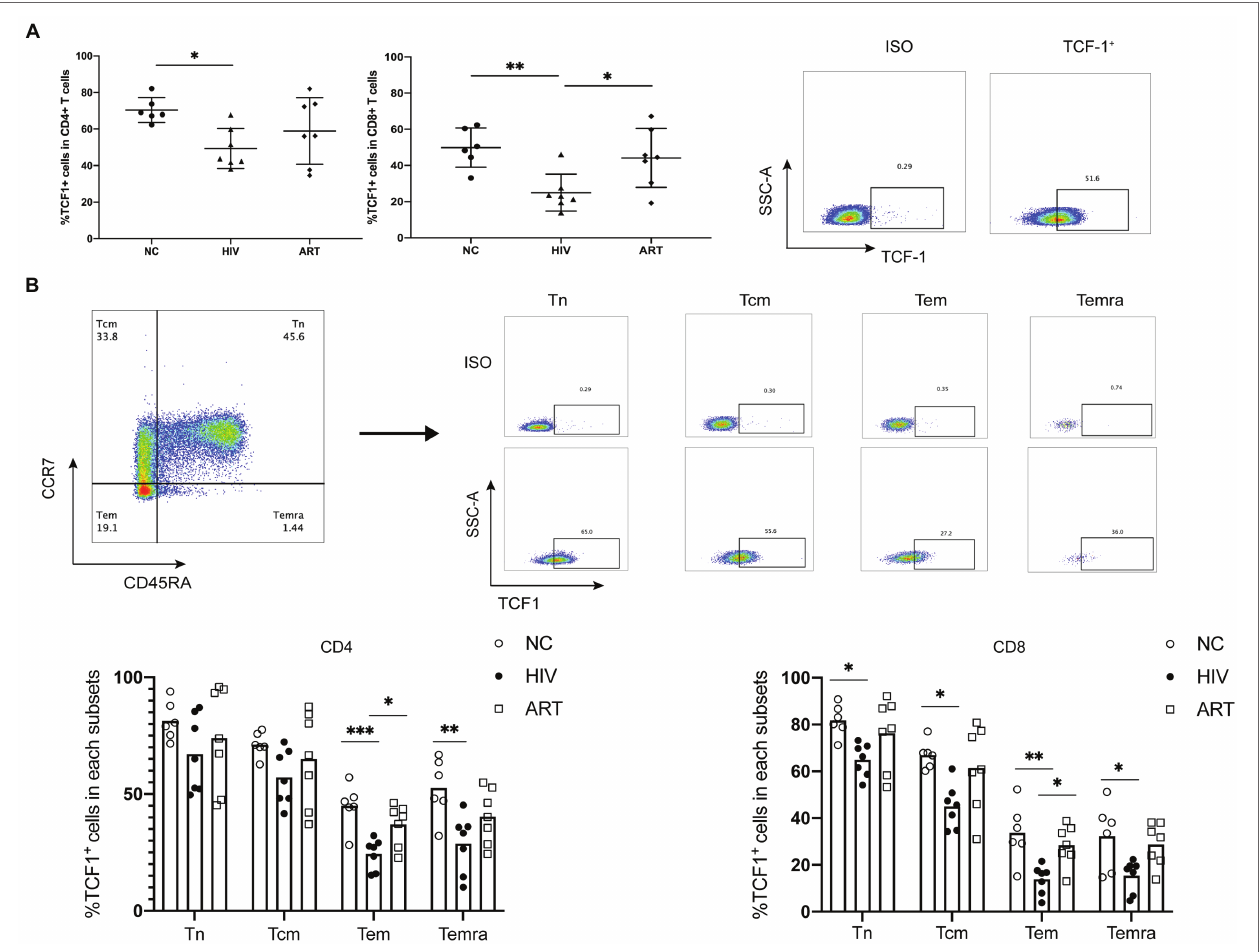
FIGURE 2 | T cell factor (TCF)1 expression is reduced in different CD4 + and CD8 + T cell subsets from HIV-infected individuals. (A) The percentage of TCF1 + CD4 + T cells and TCF1 + CD8 + T cells from treatment-naïve HIV-infected individuals (HIVs, n = 7) compared with HIV-negative control individuals (NCs, n = 6) and HIV-infected individuals receiving antiretroviral therapy (ARTs, n = 7). The TCF1 + population was gated based on the ISO from the same individual. (B) The percentage of TCF1 + cells in naïve (Tn), central memory (Tcm), effector memory (Tem), and terminally differentiated effector memory (Temra) T cell populations from CD4 + and CD8 + T cells (including HIVs, NCs, and ARTs), distinguished by the level of CCR7 and CD45RA expression. One-way ANOVA analysis was used in (A,B) . * p < 0.05, ** p < 0.01, *** p <